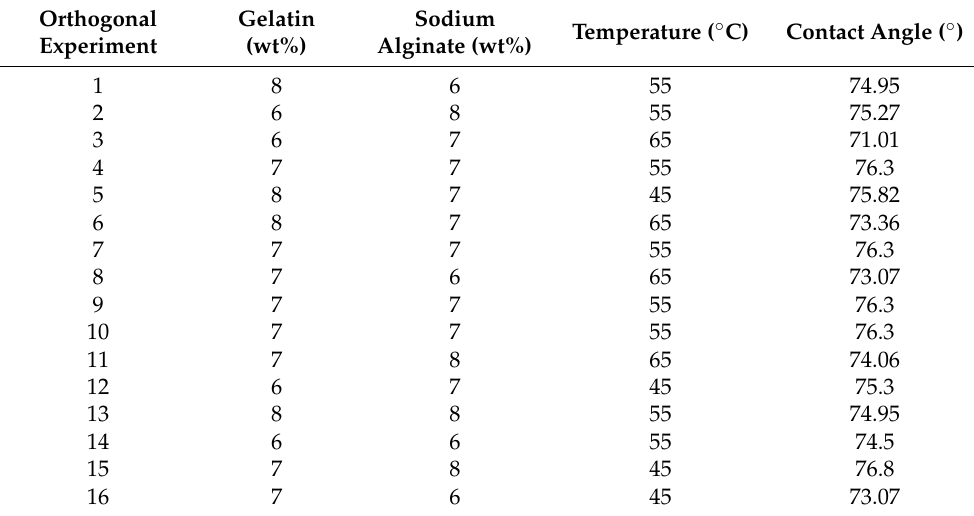
Table 1. Orthogonal experiment results ( n = 16).